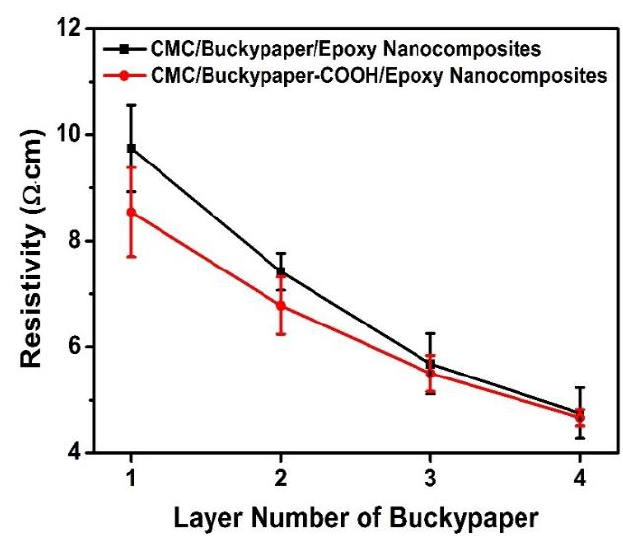
Figure 6. The resistivity of buckypaper nanocomposites.